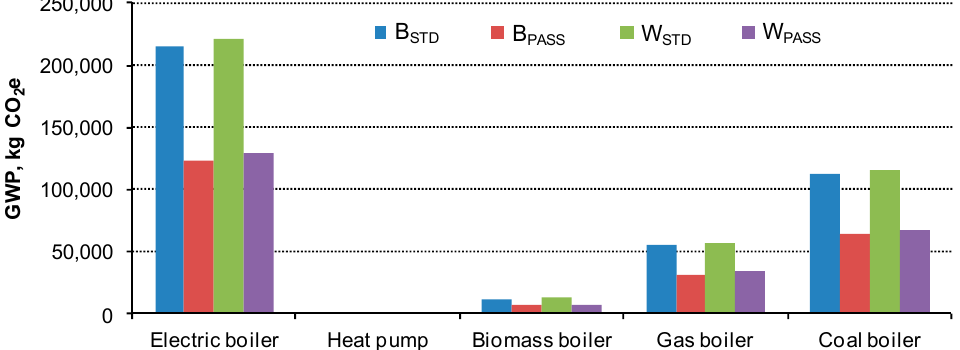
Figure 5. GHG emissions related to energy consumption for heating, depending on the type of boiler and building (25 years of and building (25 years of operation).